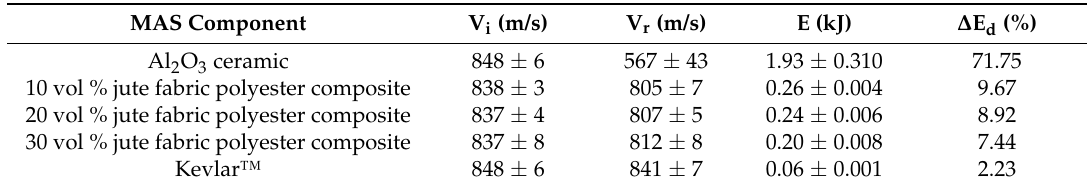
Figure 7. Ballistic test to measure the impact and residual velocities after perforation of a jute fabric composite plate: ( a ) before and ( b ) after bullet impact. Table 3. Impact and residual velocities together with internally dissipated energy in individually ballistic tested MAS components.